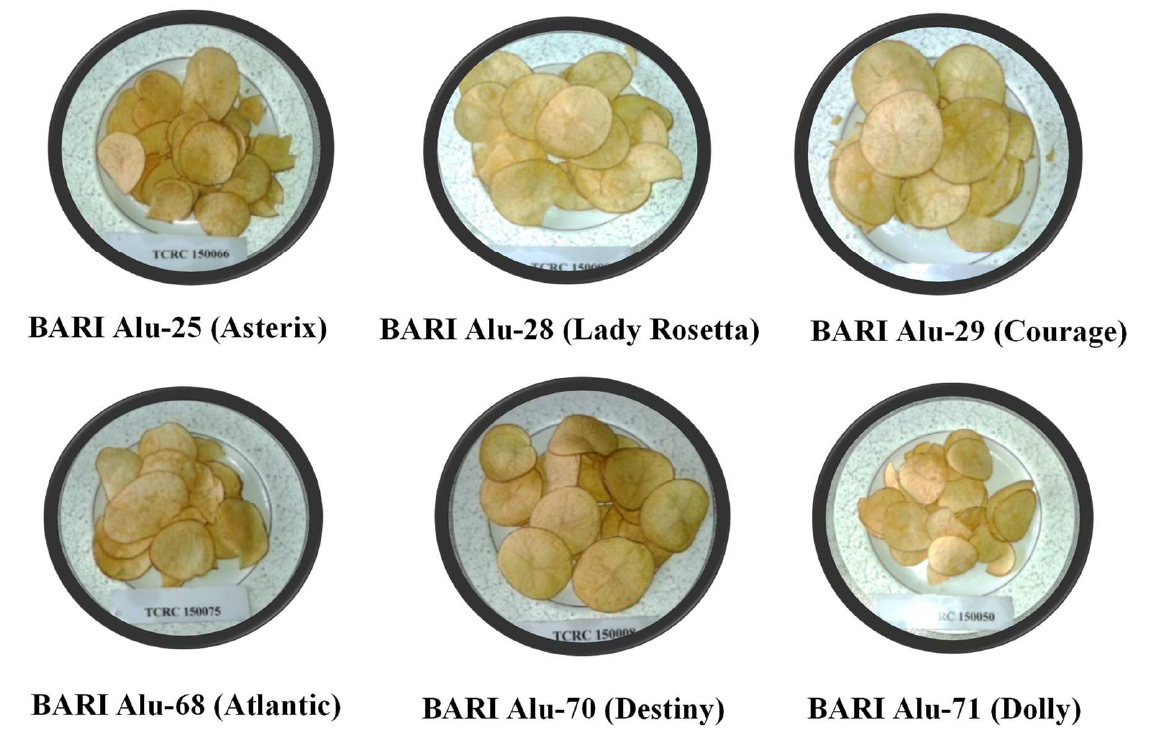
Figure 2. Chips color of various processing varieties. Table 5. Different sensory attributes (appearance, taste, aroma, overall acceptability) of potato